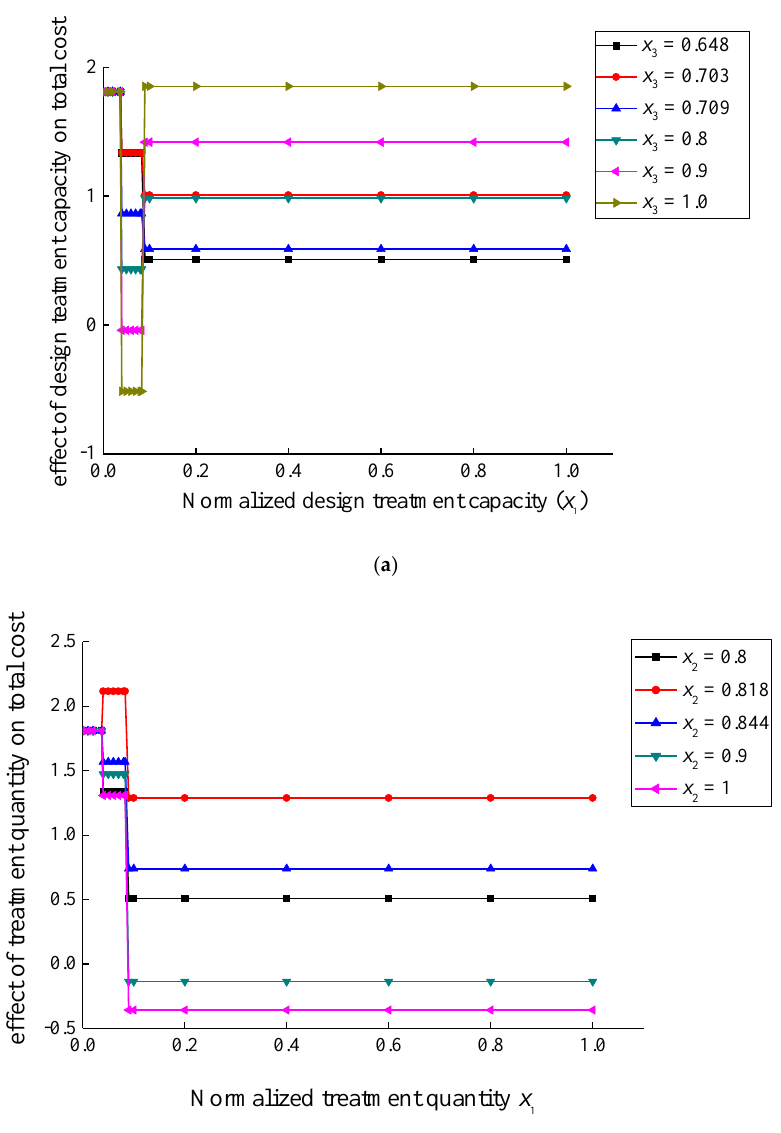
Figure 3. ( a ) Effect of design treatment capacity x 1 on total cost under different x 3 without consideration of x 2 < 0.8. ( b ) Effect of design treatment capacity x 1 on total cost under different x 2 without consideration of x 3 ( x 3 < 0.648).